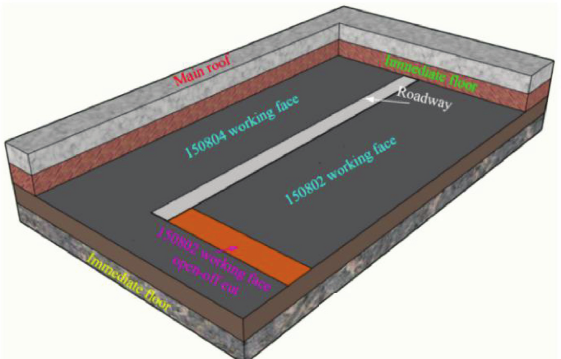
Figure 16: Adhesive tape arrangement on the 150802 working